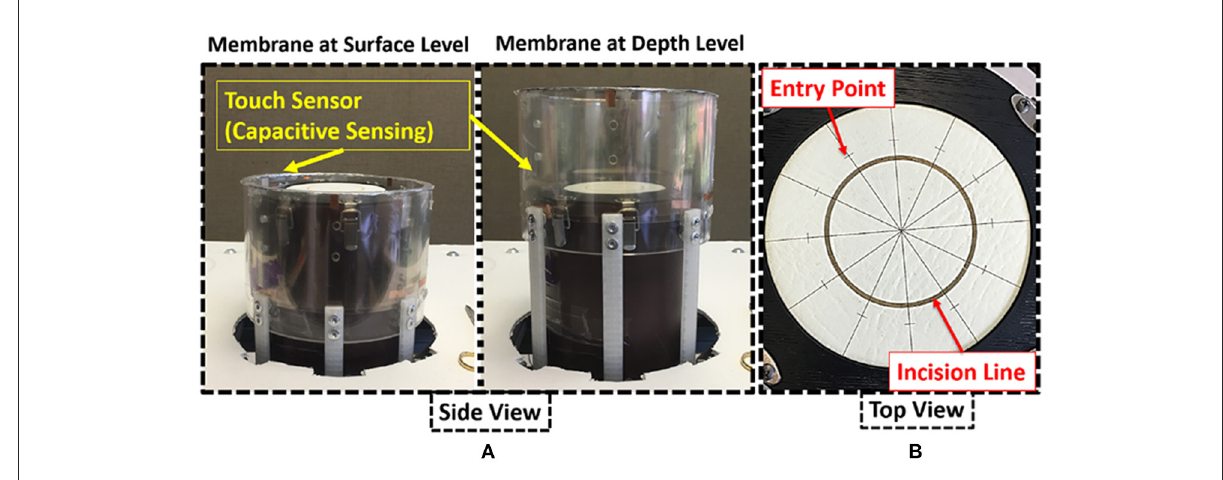
FIGURE2 (A) membrane housing, (B) suture